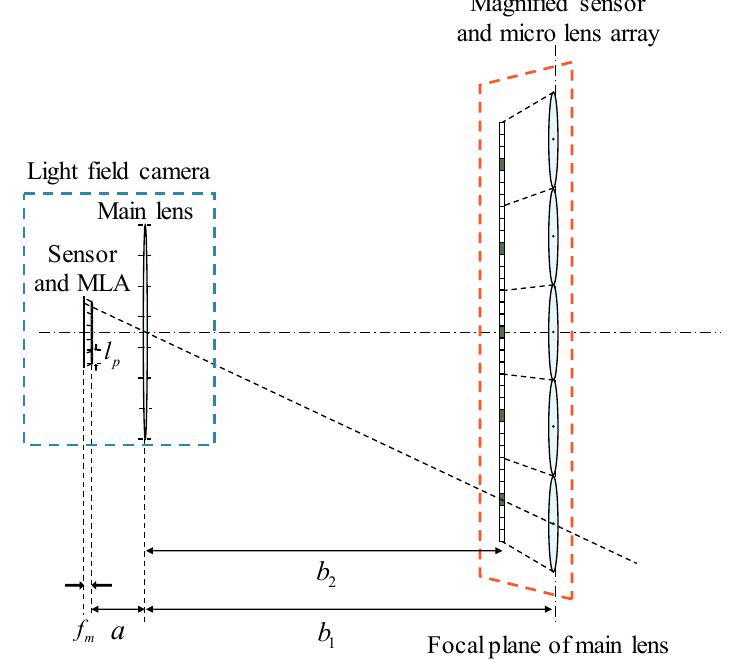
Figure 1. Geometry structure of light field camera. MLA: micro lens array